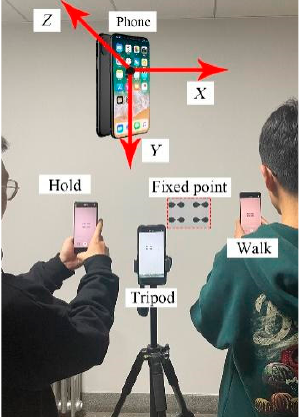
Figure 10. Directions for testers to take pictures and smartphones.